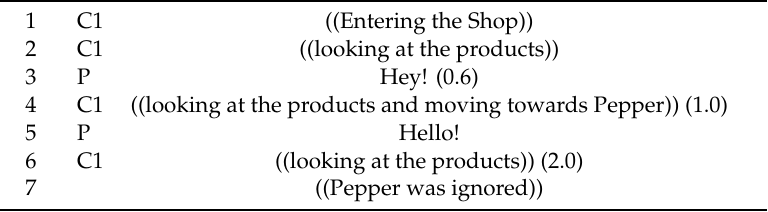
Table 2. Conversation in baseline condition (20 September 2018).